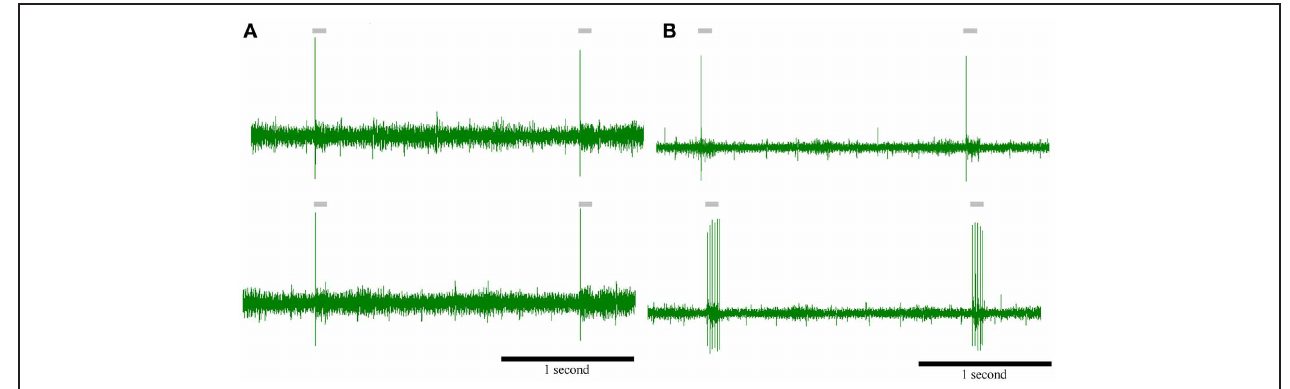
FIGURE 9 | Intense peripheral stimulation can transform a phasic neuron to tonic. Top: responses of two phasic PrV neurons to peripheral stimulation of the principal whisker (control). Bottom: responses of the above phasic PrV neurons to peripheral stimulation of the principal whisker after intense